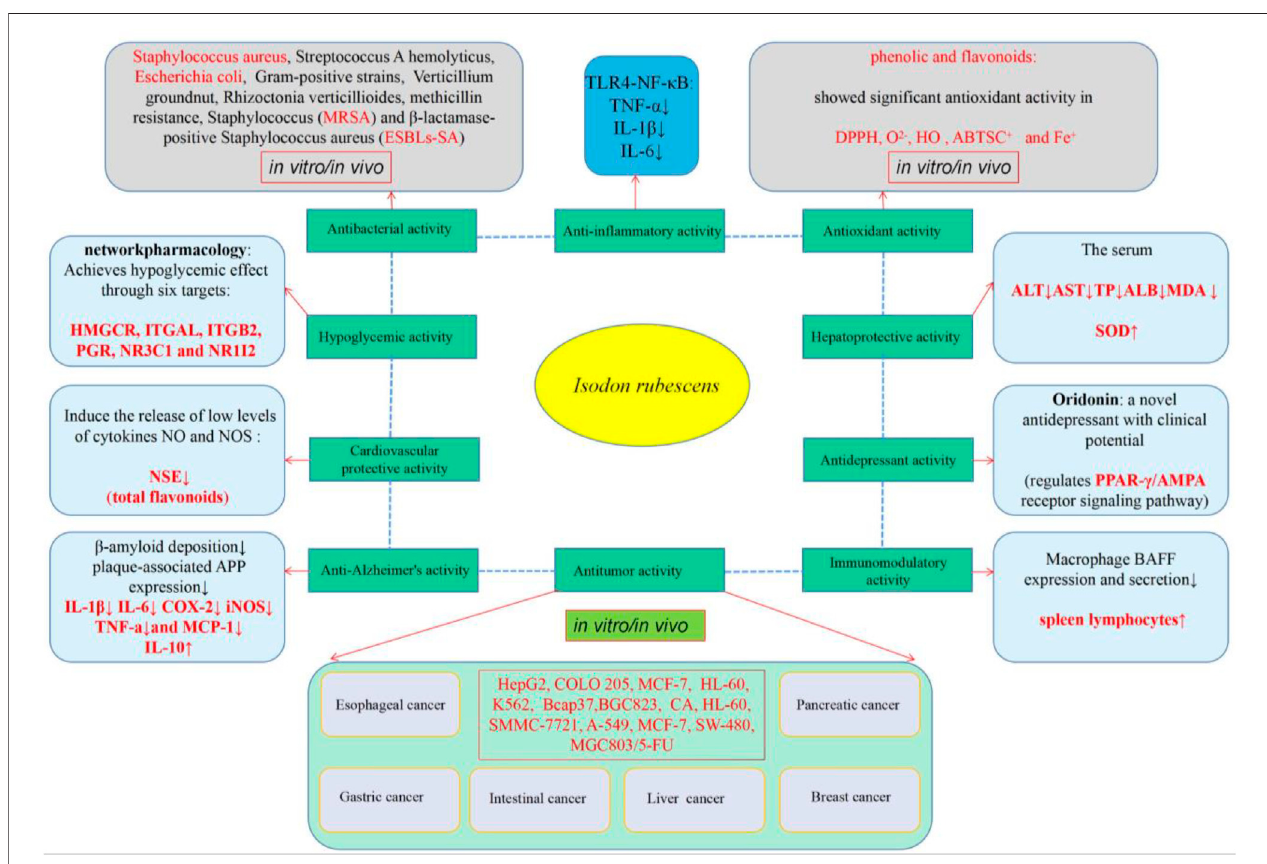
FIGURE 4 | Graphical summary of pharmacological properties of I. rubescens